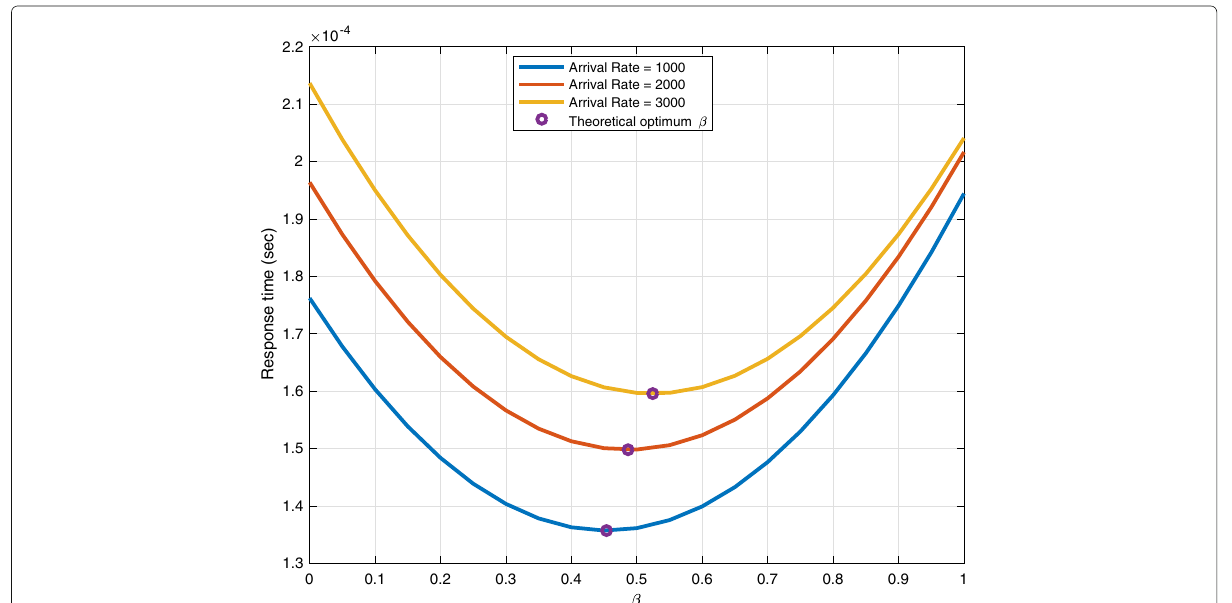
Fig. 11 Comparison of optimum β values while γ = 15 and λ is changing. Arrival rate=1000, Arrival rate=2000, Arrival rate=3000, Theoretical optimum β